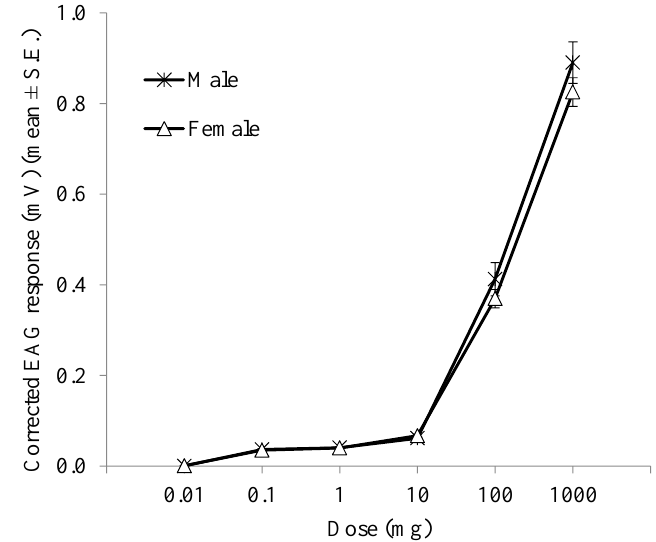
Figure 2. EAG dose-response curves of male and female A. bungii distal flagellomeres (seventh to ninth) to ascending doses of ( Z )-3-hexenol.